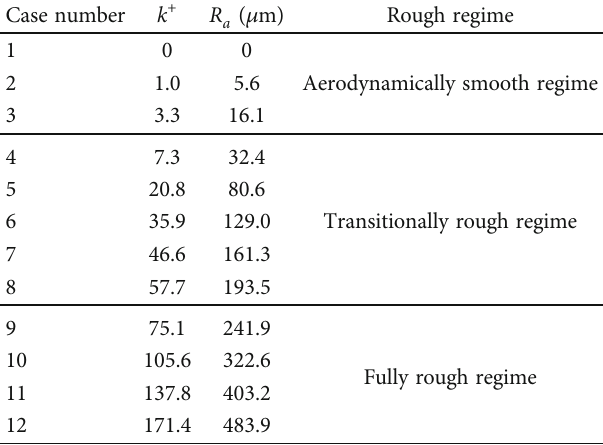
Figure 5: Sketch of the test rig, compressor, and rotor. Table 3: Roughness magnitudes on the rotor blade